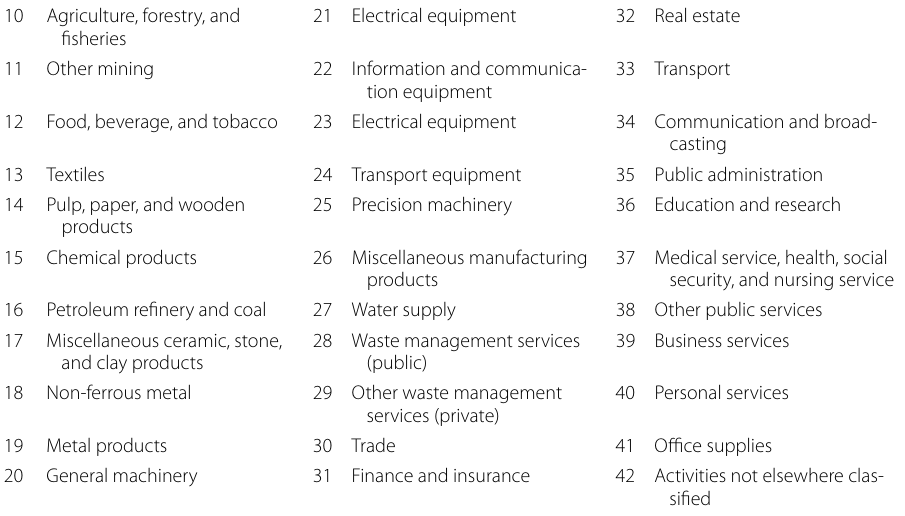
The classification numbers follow that of industry related to non‑metallic mineral wastes in Table 2